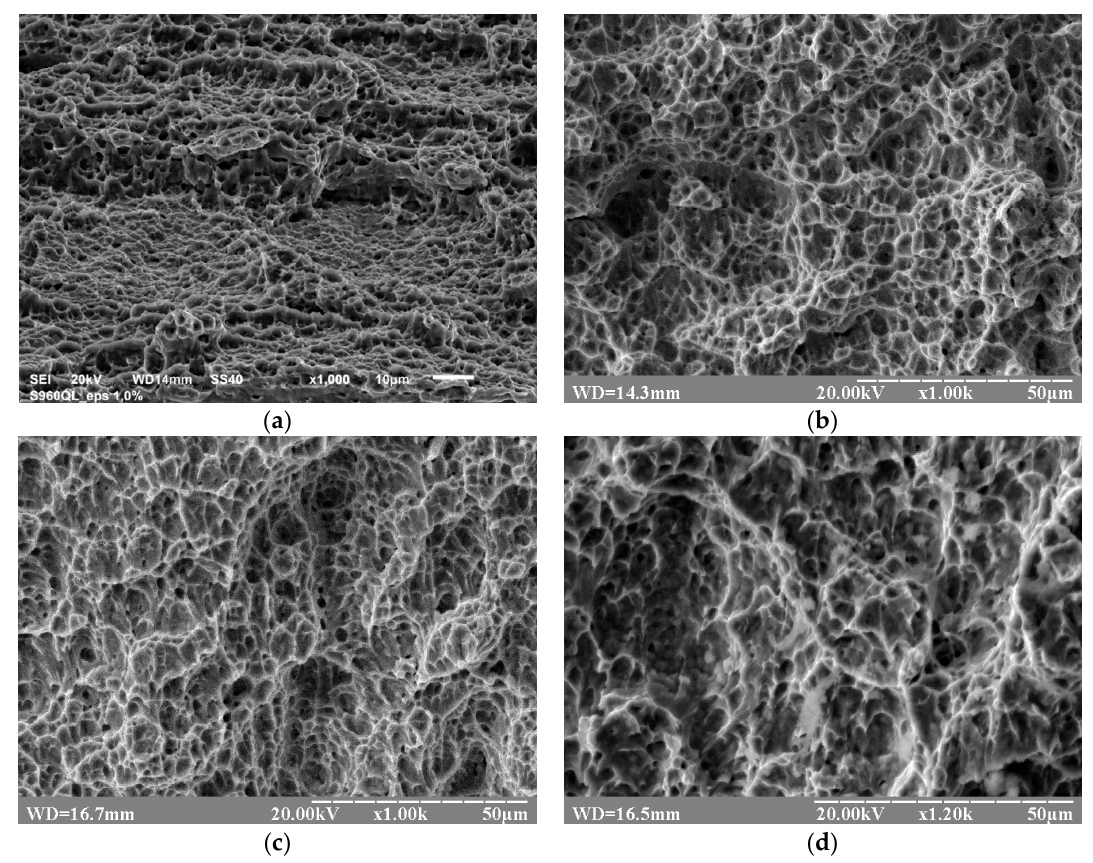
Figure 1. SEM images of fracture surfaces of specimens from alloys VT23 ( a ) and VT23M ( b – d ) under static ( а , b ) and impact ( с , d ) loading.